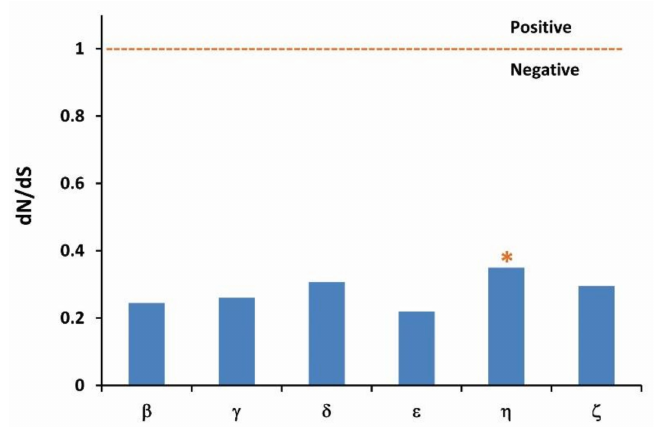
Figure 3. Selection pressure imposed on the OR groups. The asterisk (*)-indicates that group η exhibits the highest dN/dS